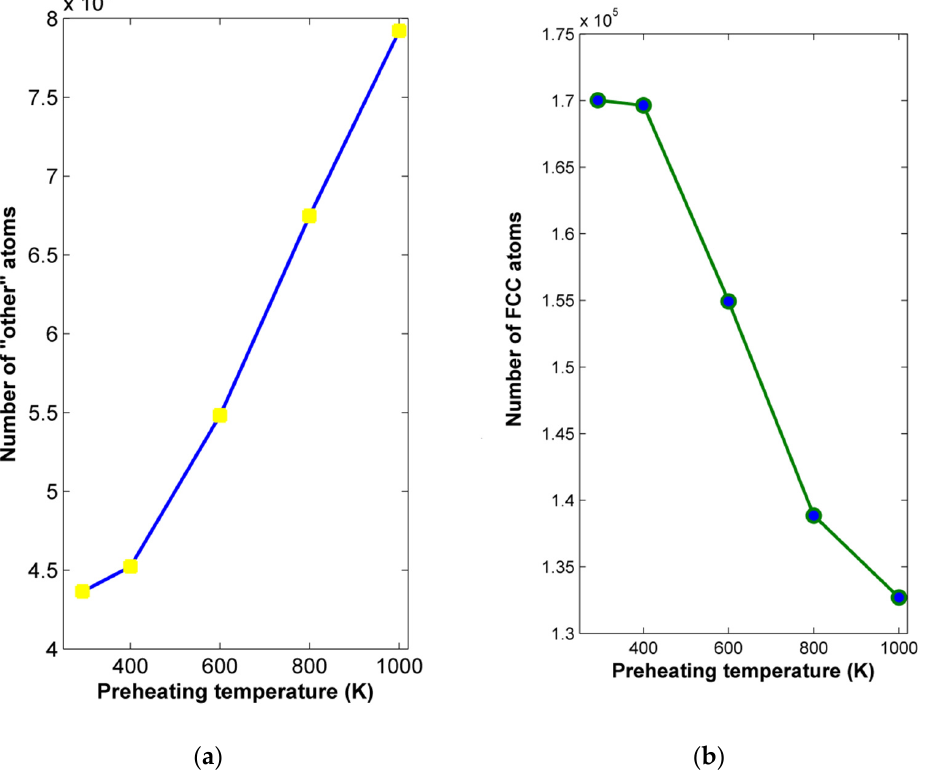
Figure 10. Variation of: ( a ) “other” atoms and ( b ) fcc atoms with respect to preheating temperature.